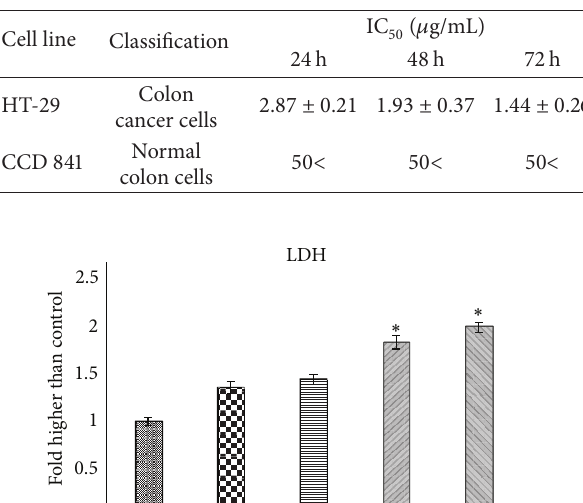
Table 1: Inhibitory effects of Cu(BrHAP) human normal and cancer cells. Cells were treated with various concentrations of Cu(BrHAP) were analyzed by nonlinear regression analysis.